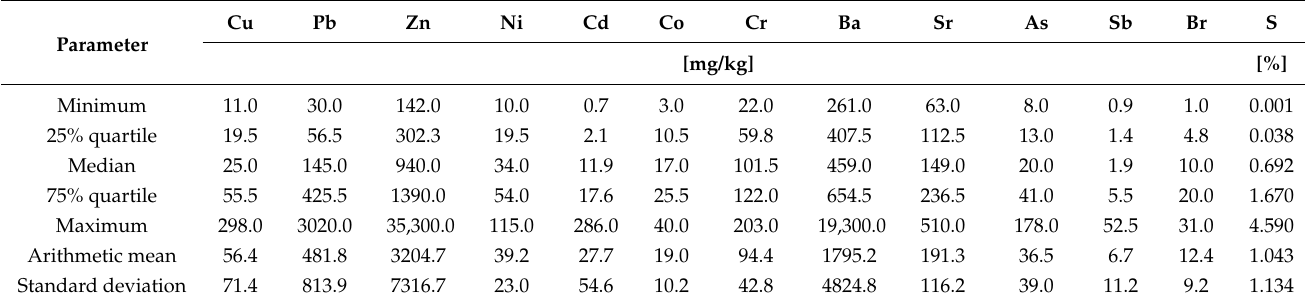
Table 2. Basic statistical characteristics of metal and non-metal concentrations in the bottom sediments of water bodies used for recreational purposes in the Silesian Upland and its periphery.